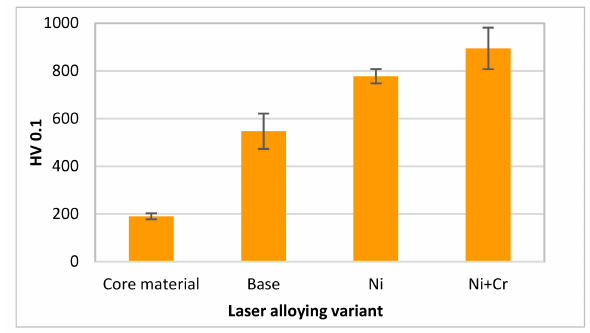
Figure 13. The average value of surface layers hardness.